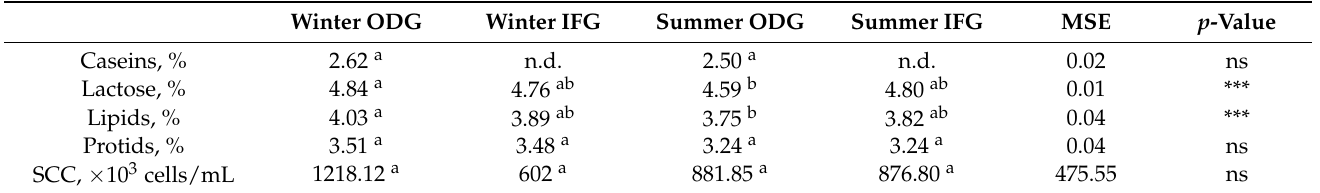
Table 1. Chemical composition in bovine milk samples collected in two seasons (summer and winter) from two different feeding systems. Winter ODG Winter